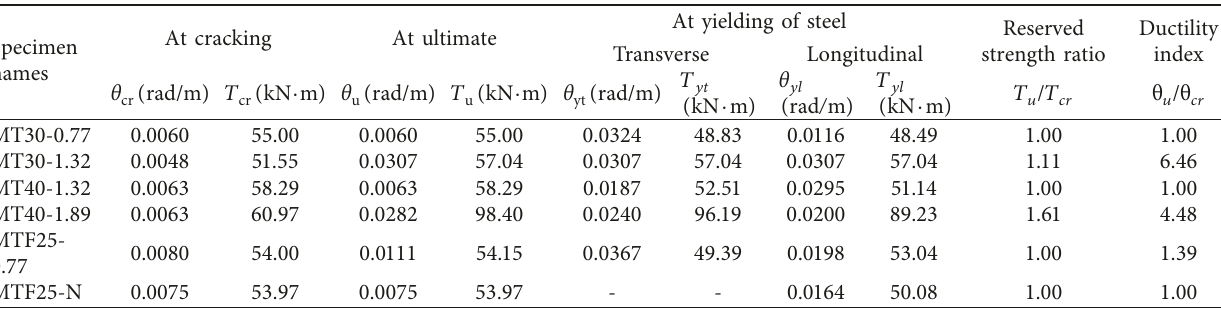
Figure 7: Fractions of SFRC members: (a) MTF25-0.77; (b) MTF25-N. Table 3: Test results and validation of the proposed